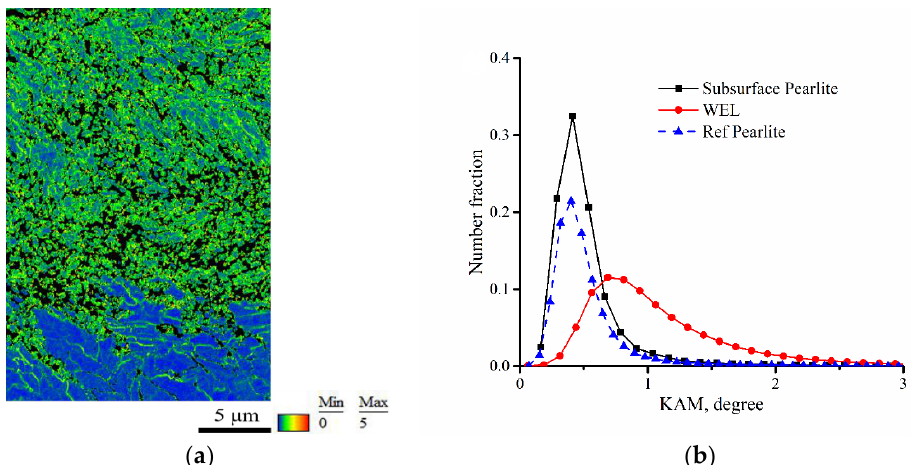
Figure 4. ( a ) KAM map of the WEL specimen, using 5° and 1st neighbor and ( b ) KAM plot of ferrite in the WEL and pearlite underneath the WEL.